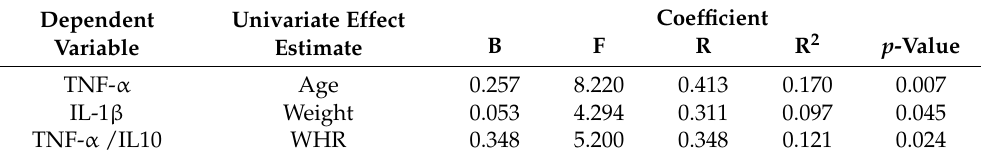
Table 8. Significant correlations of cytokine and ratio levels with trial variables at follow-up.